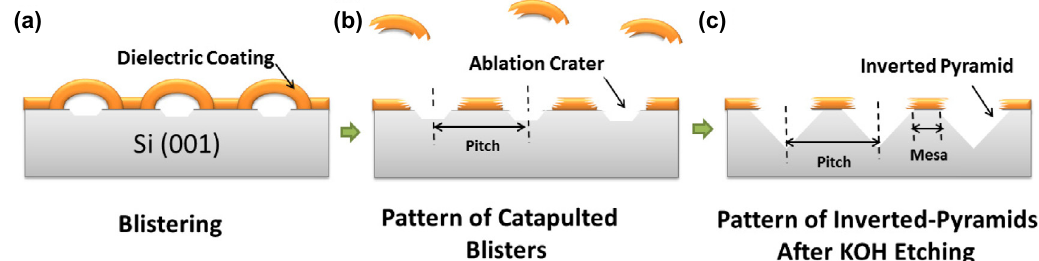
Fig. 1. A schematic illustrating (a) blistering of a dielectric coating upon interaction with femtosecond pulses, (b) catapulting of the blisters at higher laser fluence to form a pattern of shallow ablation craters in c-Si, and (c) the resulting inverted-pyramid structure following KOH